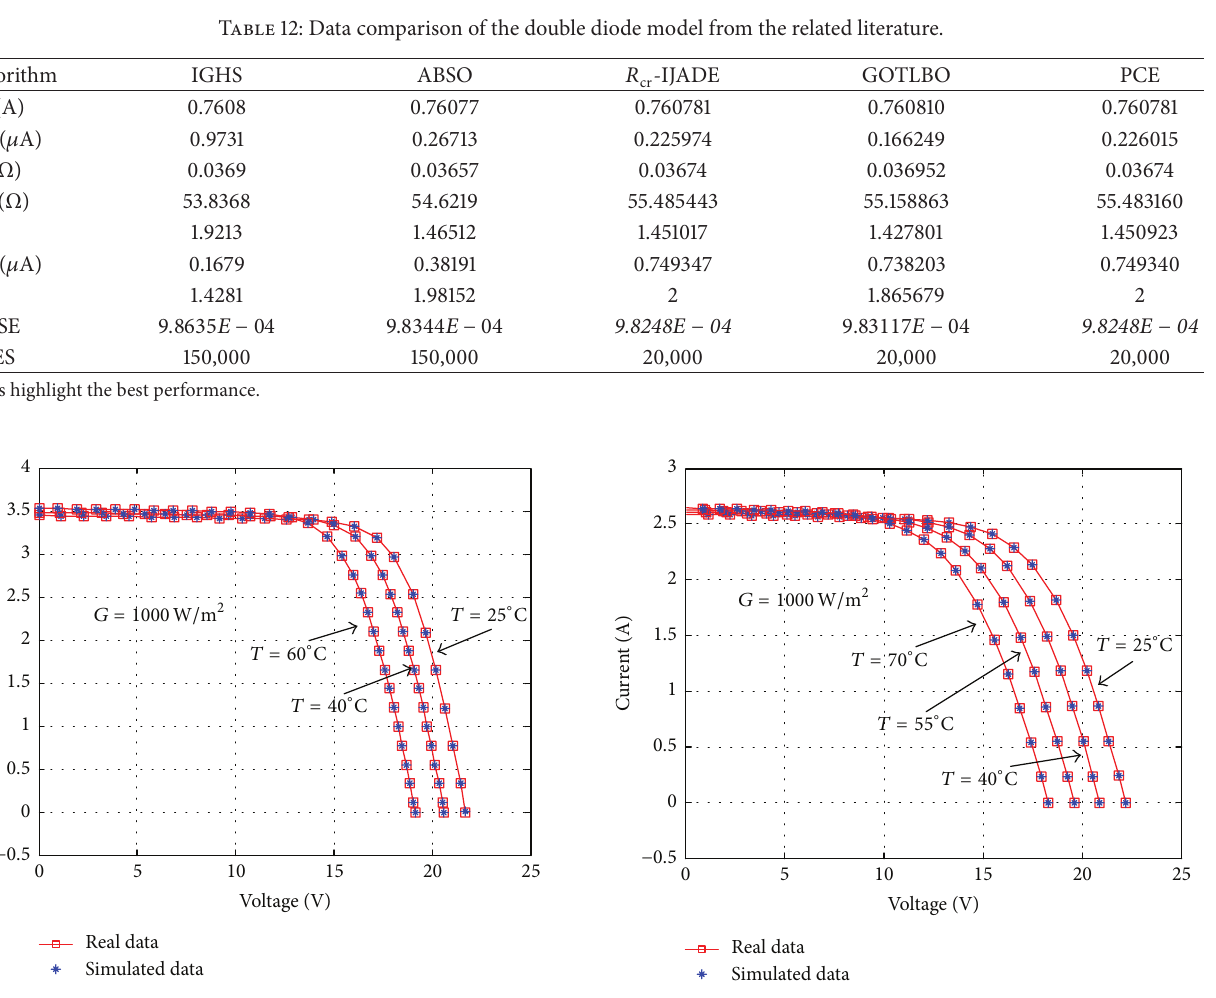
Figure 7: Comparison between real data and the simulated data by PCE for monocrystalline SM55 at different temperatures.